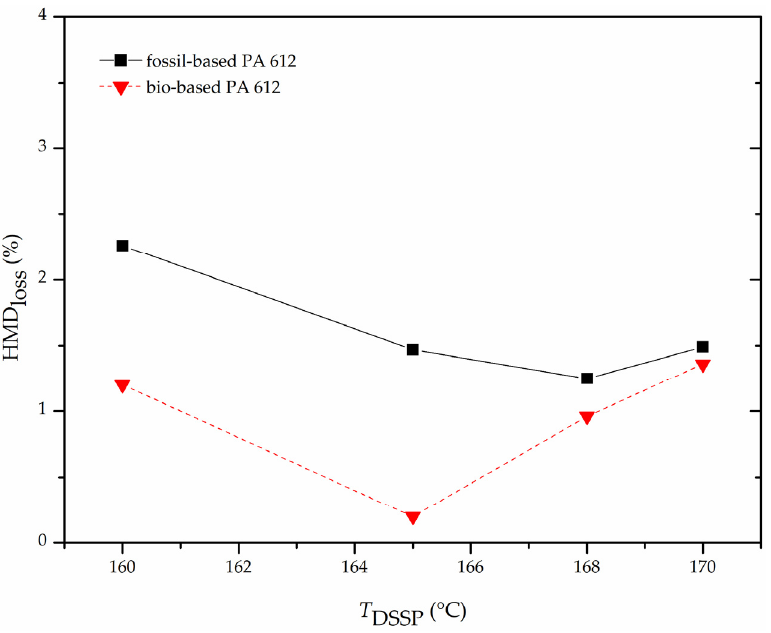
Figure 6. DSSP diamine loss for fossil-based and bio-based PA 612 salt.